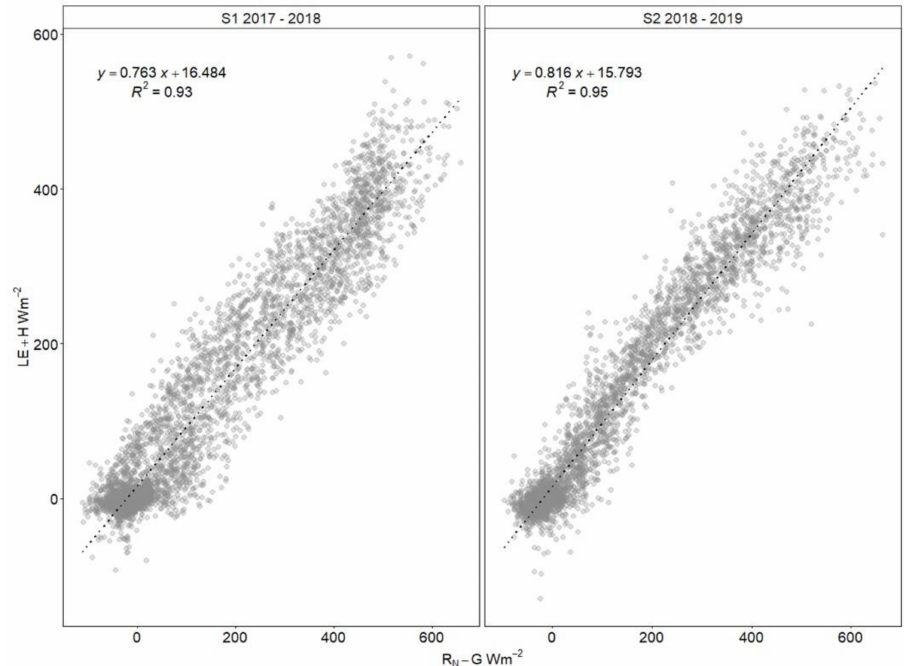
Figure 3. Energy balance closure analysis based on 30 min averages during seasons S 1 (November 2017–March 2018) and S 2 (November 2018–March 2019). The dotted line is the regression line that describes the response of LE + H to RN -G